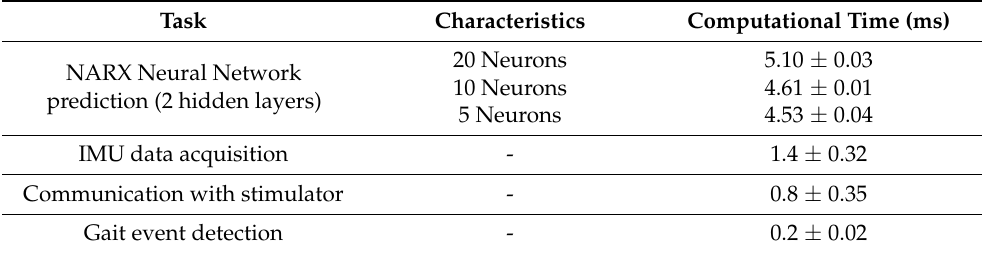
Table 2. Mean computation times obtained from the FES system